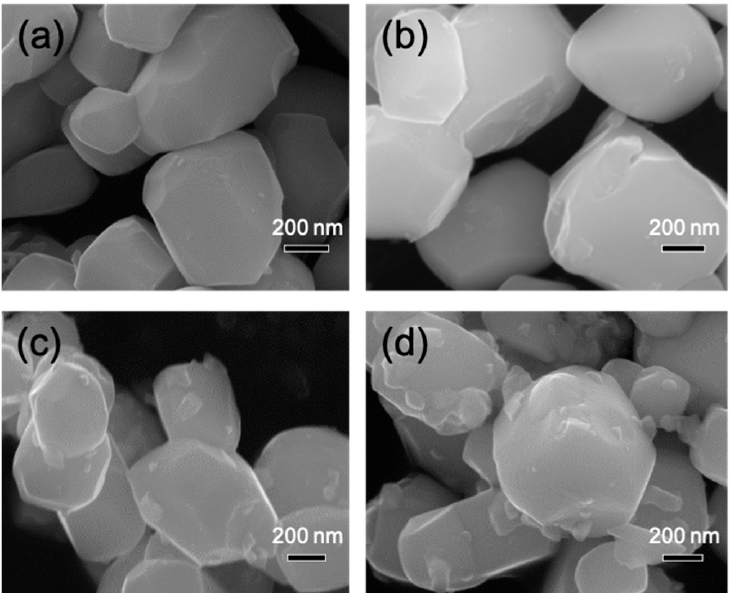
Figure 4. SEM images of BaTiO 3 employed for hydride reduction ( a ), of BTOH ( b ), of BTON-600C-0 h ( c ), and BTON-600C-6 h ( d ).